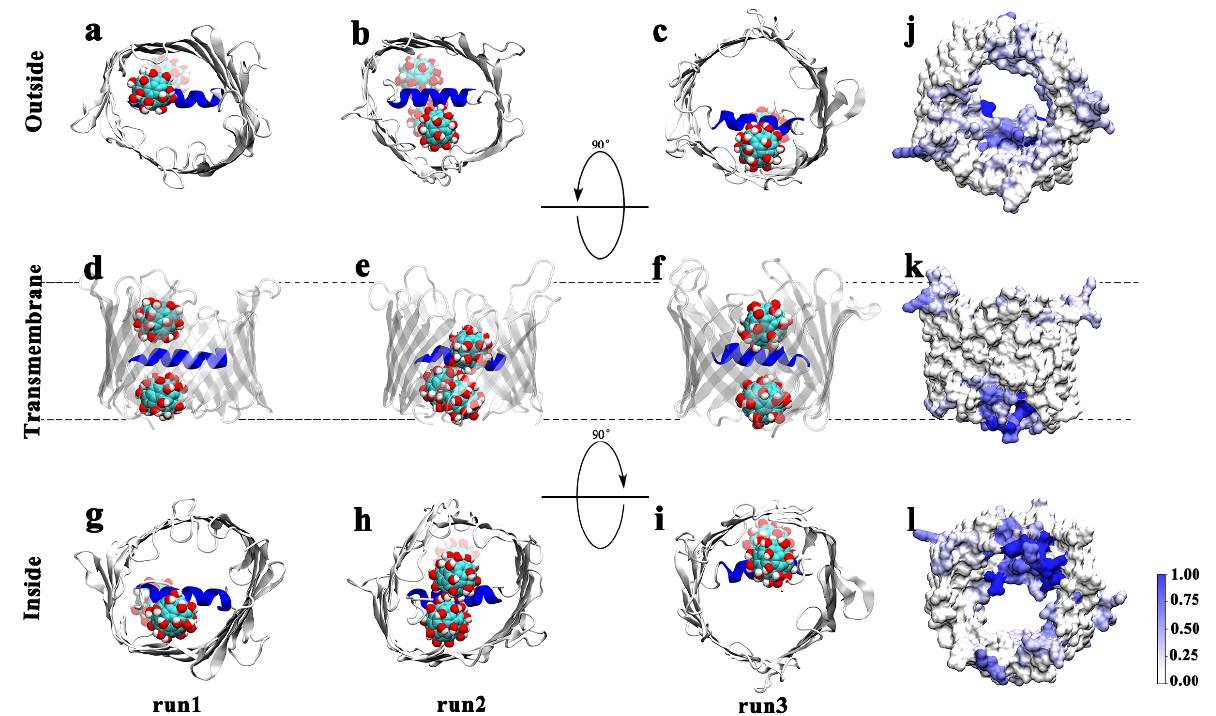
Figure 2. ( a – i ) Final snapshots taken from representative runs 1–3 obtained at the end of hundred- nanosecond MD simulations. The location of the membrane is indicated by the black dashed line in the middle row ( d – k ). For each run, the binding site of Gd@C 82 (OH) 22 in the hVDAC1 is shown from the side view (middle), the top view from the outside of the membrane (top, to show the OM penetration), and the bottom view from the inside of the membrane (bottom, to show the IM penetration). ( j – l ) Average contact probability of Gd@C 82 (OH) 22 on the hVDAC1 surface statistics obtained from the three runs.